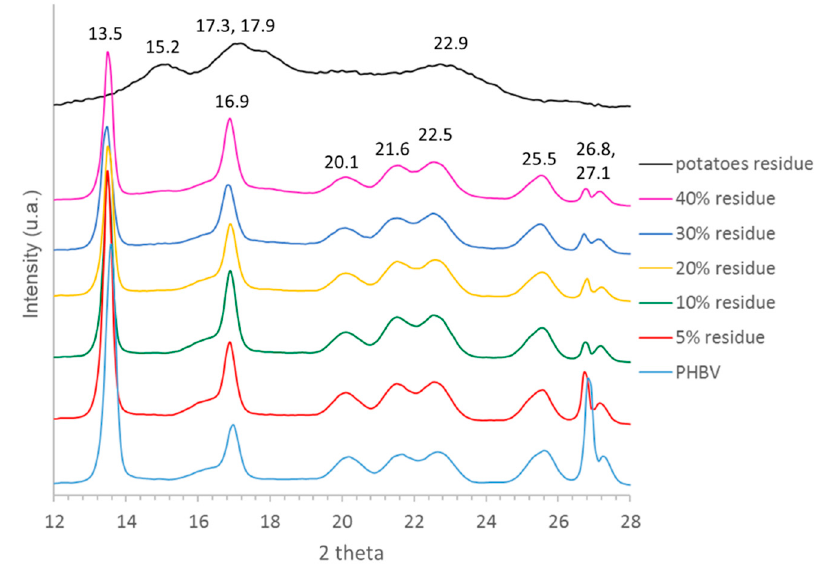
Figure 9. X-ray diffractograms of the sweet potato residue, polymeric matrix and related bio-com- posites.